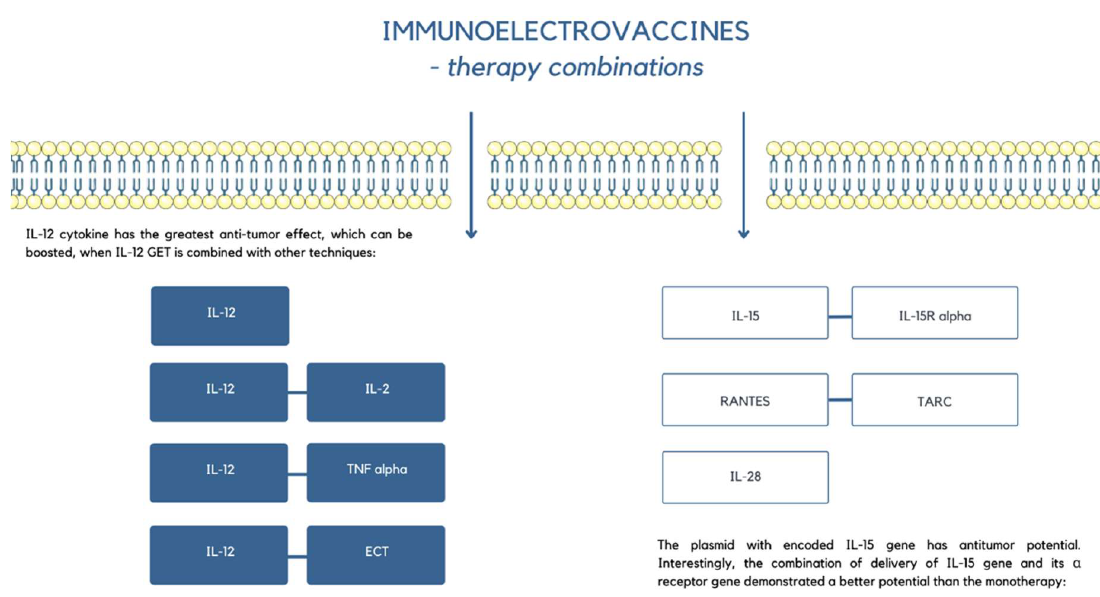
Figure 6. Types of DNA vaccines and their functions [3,110,113]. The Figure was partly generated using Servier Medical Art, provided by Servier, licensed under a Creative Commons Attribution 3.0 unported